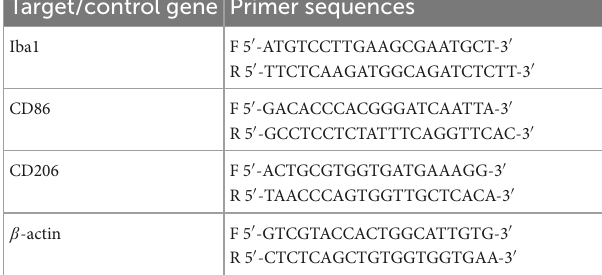
TABLE 1 Real-time PCR primers used in this study. Target/control gene Primer